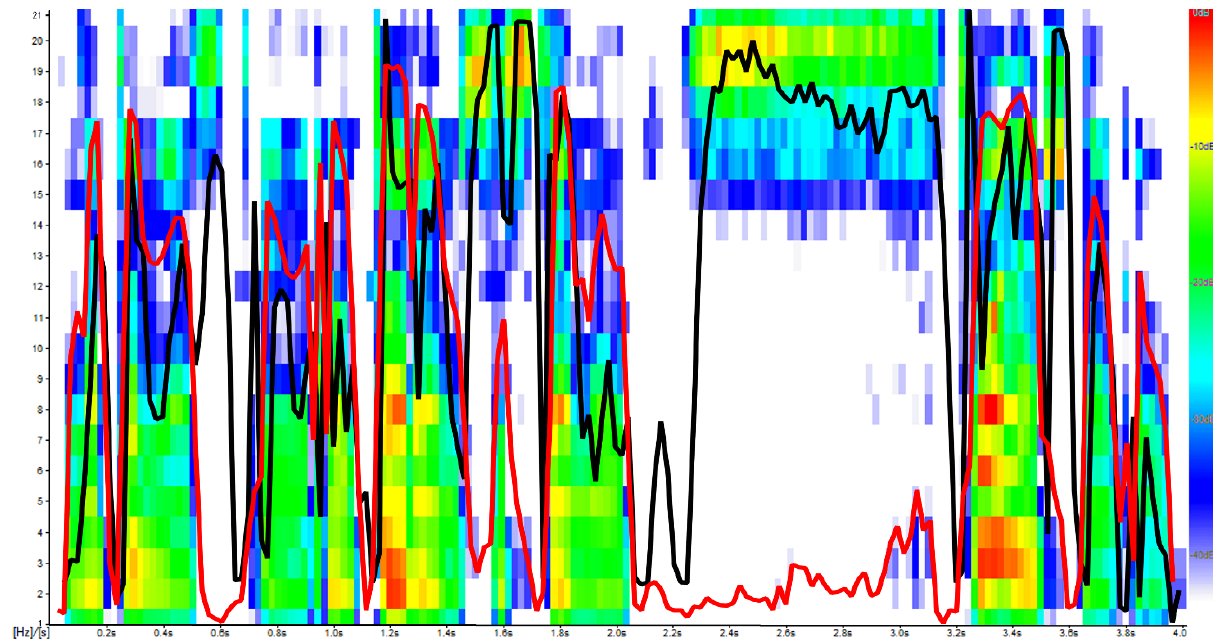
Figure 4. Second component (G 2 ) factor loadings.